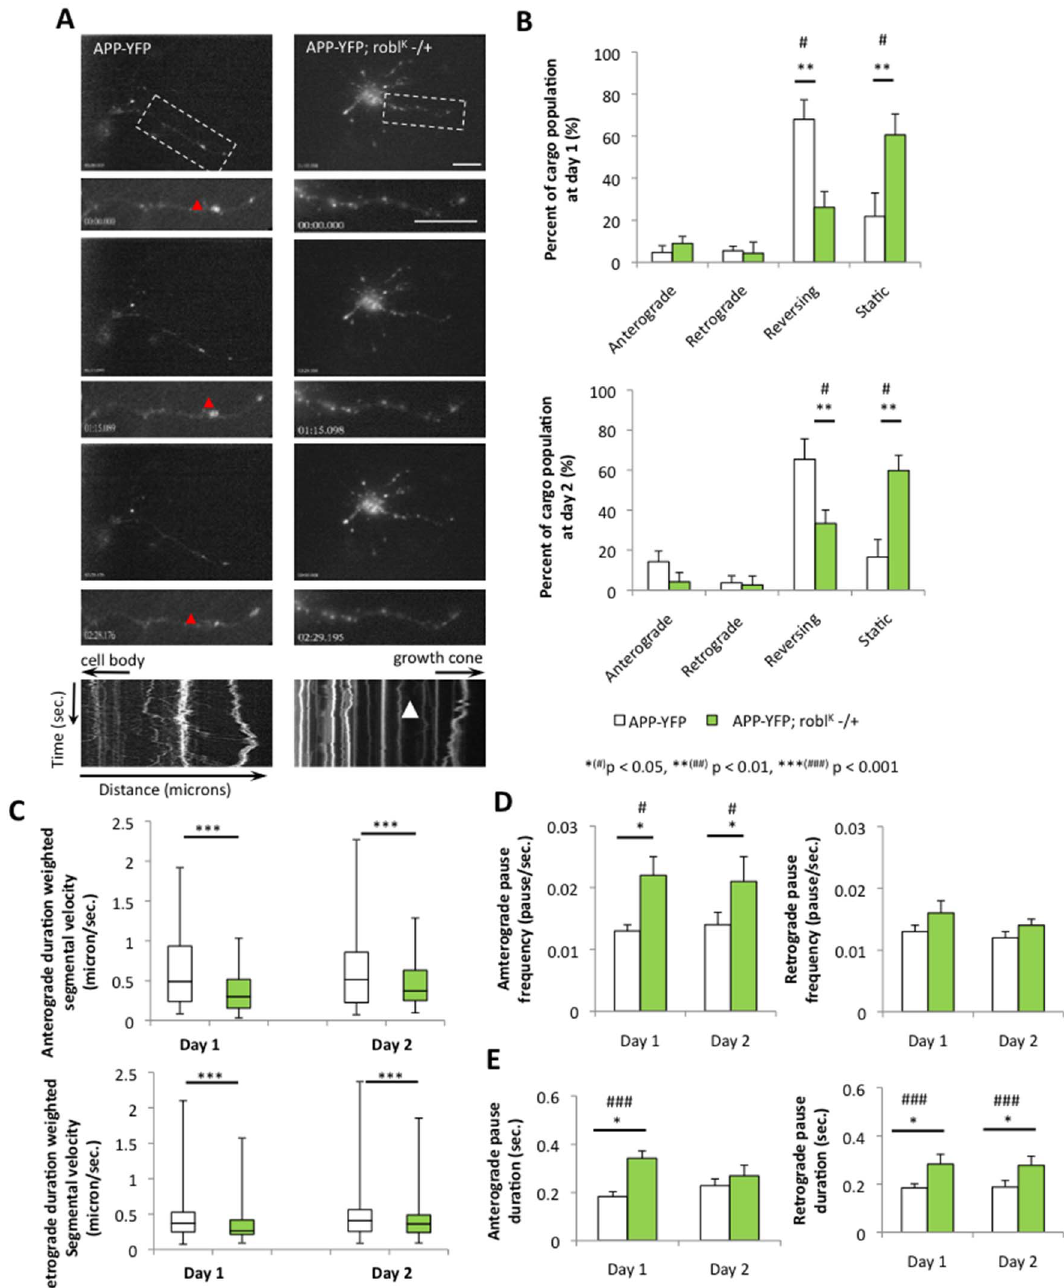
Figure 5. 50% Reduction of dynein perturbs the movement of APP vesicles. ( A ) A representative movie montages from a single neuron is shown from a primary neuronal culture expressing APP-YFP in the context of 100% dynein (APP-YFP) or 50% dynein (APP-YFP; robl K 2 / + ). The boxed region shows the enlarged axonal neurite with its kymograph. In the kymographs, the X-axis represents the distance, while the Y-axis represents the time. The cell body and growth cone are indicated with the arrows. 50% reduction of dynein (APP-YFP; robl K 2 / + ) led to many stalled vesicles (arrowhead) in contrast to many moving vesicles observed with 100% dynein (APP-YFP, red arrowhead). ( B ) 50% reduction of dynein significantly increased the percentage of stationary vesicles (p day1 =0.003 and p day2 =0.002) and decreased the percentage of reversing vesicles (p day1 =0.004 and p day2 =0.002) at both day 1 and day 2. ( C ) Both the anterograde (p day1 =1.814E-6 and p day2 =0.0004) and retrograde (p day1 =0.0005 and p day2 =6.743E-5) APP vesicle velocities were significantly decreased with 50% reduction of dynein compared to 100% dynein at both day 1 and day 2. Upper and lower box edges represent 75 th percentile and 25 th percentile, respectively. Upper and lower whiskers represent the maximum and minimum of the data, respectively. The horizontal line represents the median. Significance was determined by Wilcoxon-Mann-Whitney rank sum test for nonparametric distributions. ( D ) The anterograde pause frequency significantly increased at day 1 (p=0.021) and day 2 (p=0.042). ( E ) The anterograde pause duration significantly increased at day 1 (p=4.284E-5) while the retrograde pause duration (p=0.015) significantly increased at day 1 (p=0.015) and day 2 (p=0.043) compared to axonal neurites containing 100% dynein. (N=10 cells; *( # ) p , 0.05, **( ## ) p , 0.01, ***( ### ) p , 0.001 by two-tailed Student t-test (*) and by Bonferroni’s test ( # )). Bar=10 microns.